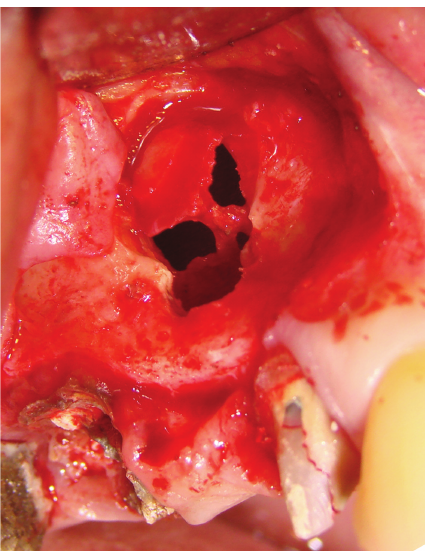
Figure 1: Image of the initial